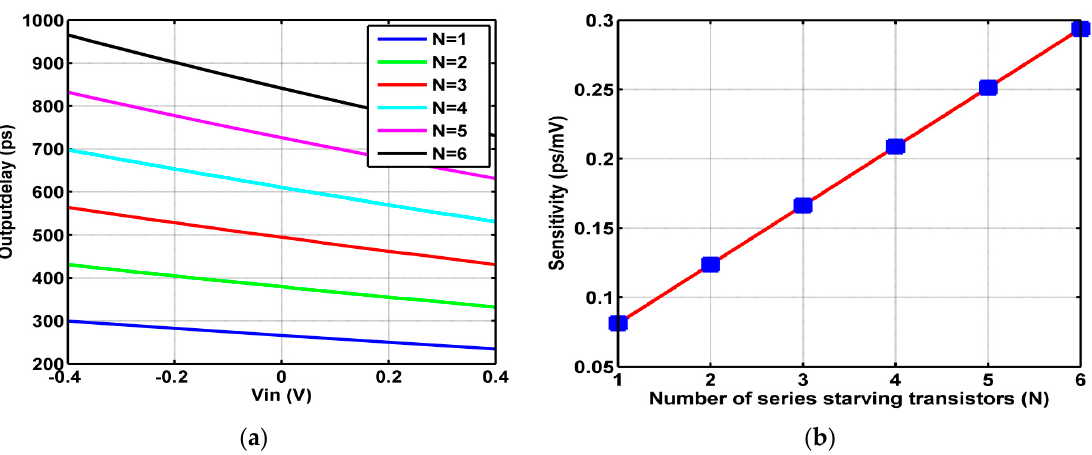
Figure 3. ( a ) Output delay versus number of series starving transistors (N), and ( b ) sensitivity versus number of series starving transistors (N).